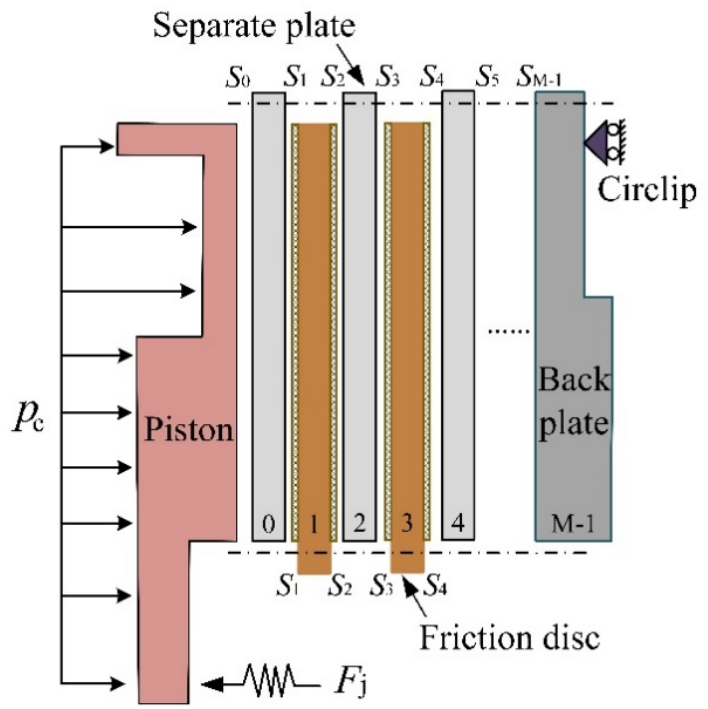
Figure 4. Simplified 2D model of the multidisc clutch.